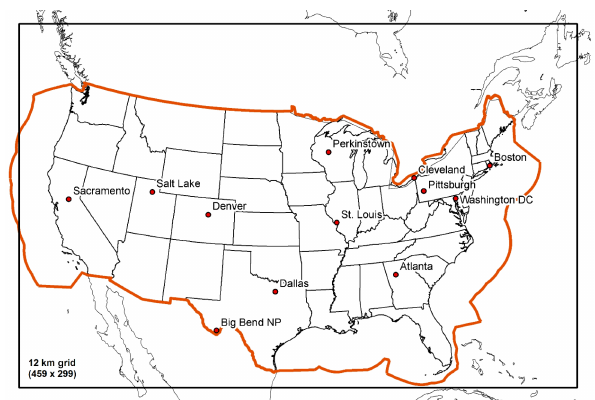
Figure 1. The modeling domain for CAMx showing monitoring sites included in the analysis. The orange line is the US Exclusive Economic Zone. Shipping emissions inside the zone were assigned to the US and outside the zone combined with Canadian and Mexi- can anthropogenic